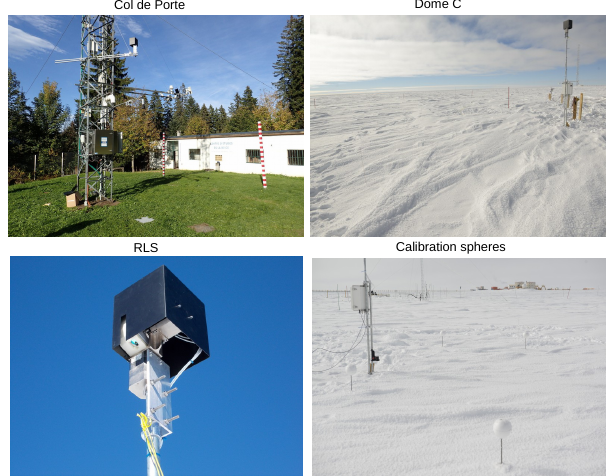
Figure 2. Pictures of RLS during the installation at Col de Porte (October 2014) and at Dome C (December 2014). Zoomed image of RLS (2-axis mount, laser meter and protection) and calibration spheres at Dome